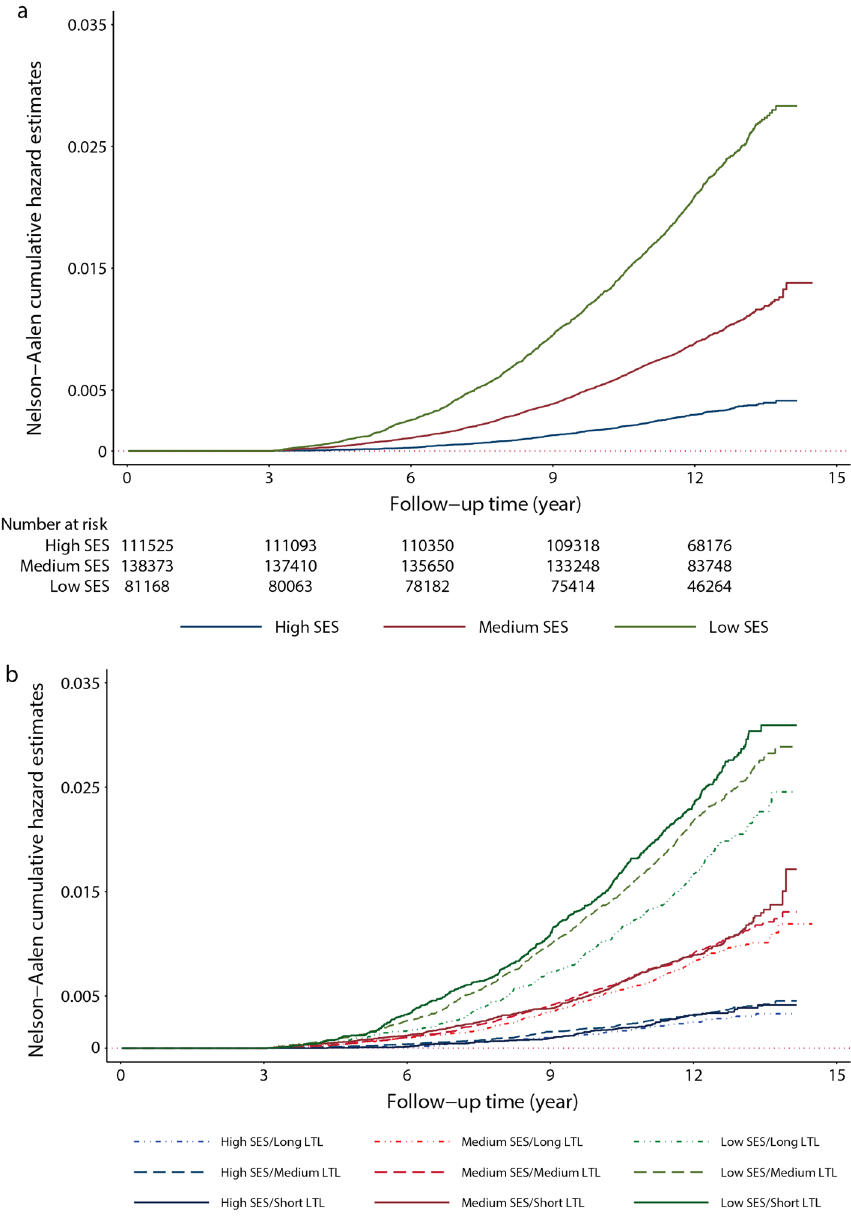
Figure 1. Nelson-Aalen cumulative hazard estimates showing cumulative risk of incident dementia. Analyses were performed based on data of 331,066 participants and stratified by: ( a ) socioeconomic status (SES) and ( b ), SES and leucocyte telomere length, LTL (residual of LTL, adjusted for chronological age, C-reactive protein and co-morbidities was employed as marker of biological age). The plotted lines represent the cumulative risk of incident dementia using Nelson-Aalen cumulative hazard